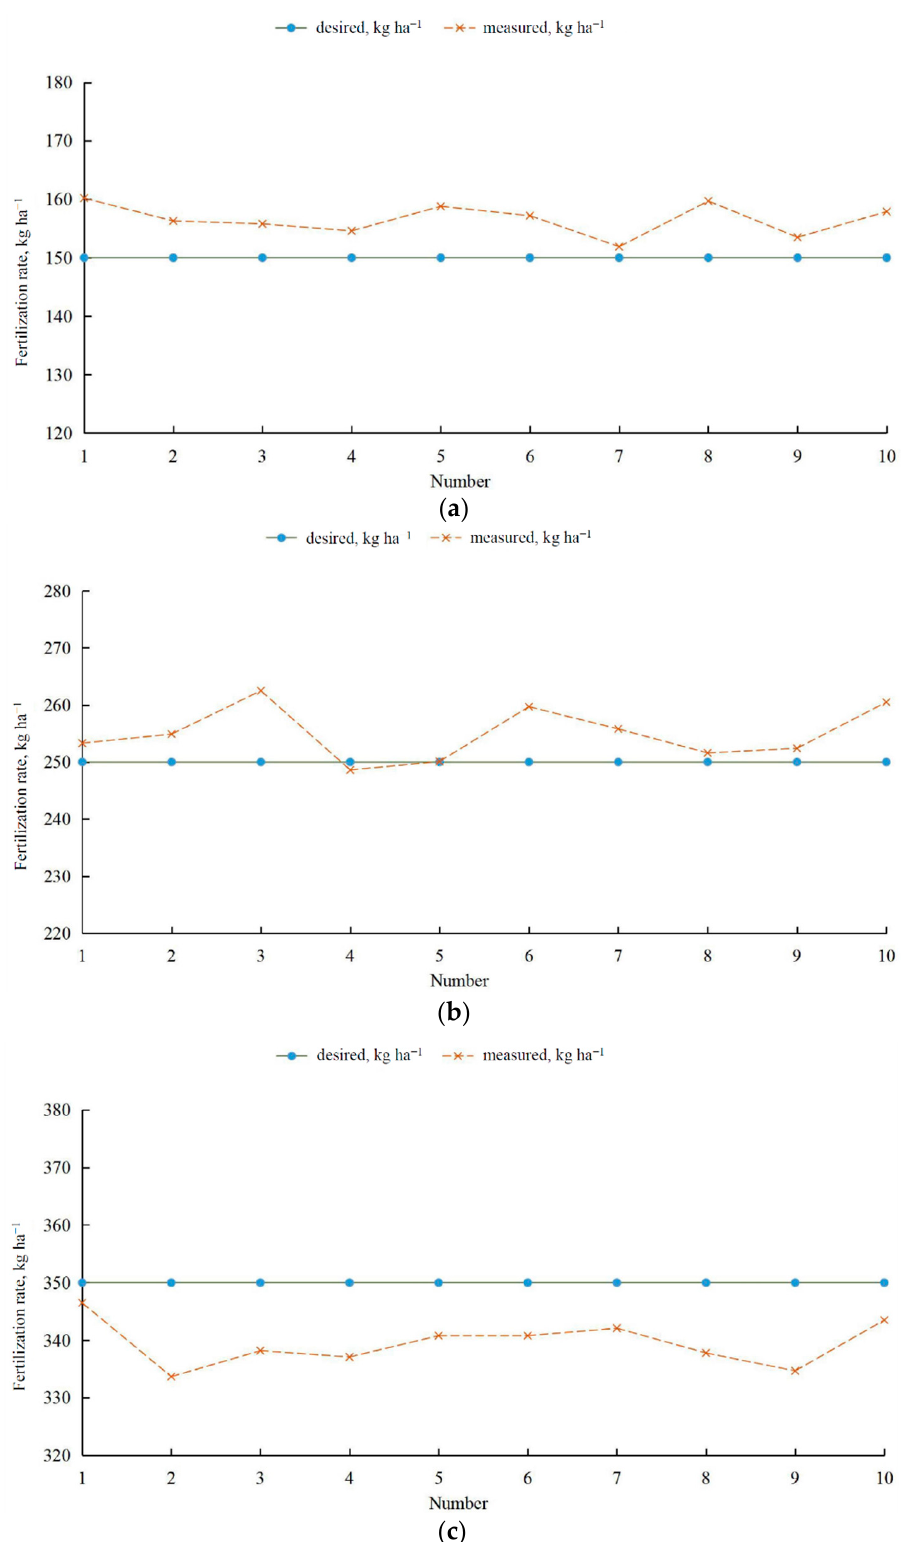
Figure 8. Desired versus measured fertilization rates for target values of ( a ) 150, ( b ) 250, and ( c ) 350 kg·ha − 1 .